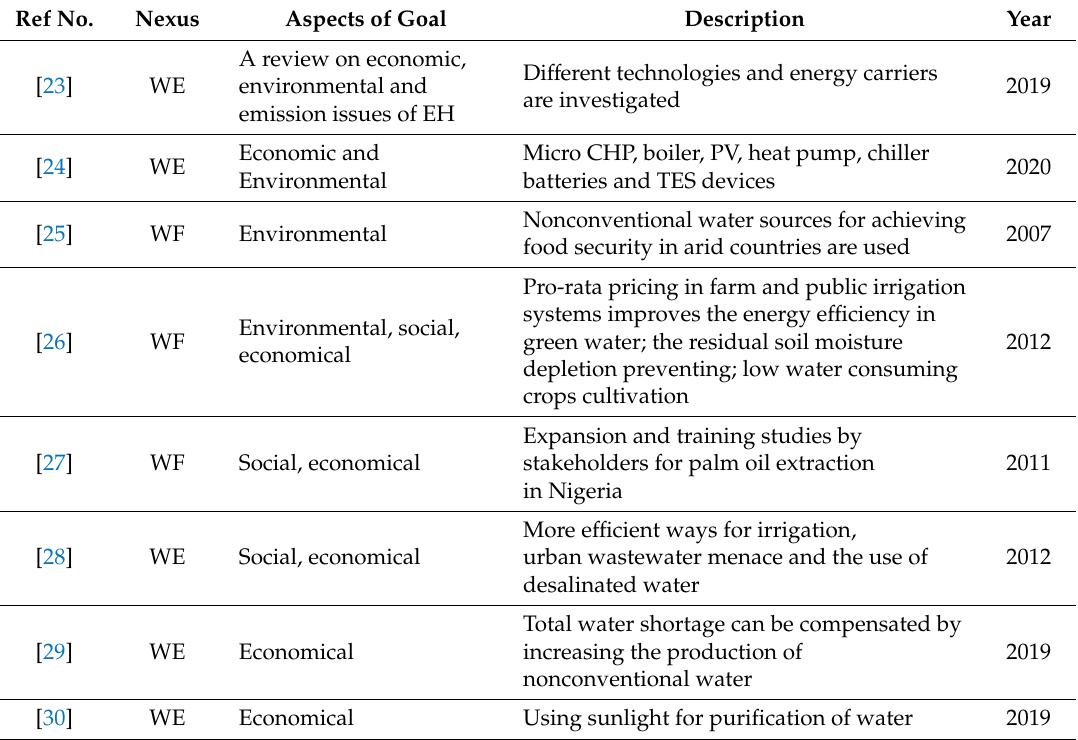
Table 2 reviews some research information on this context. Table 2. Brief information about studies in di ff erent nexus. Ref